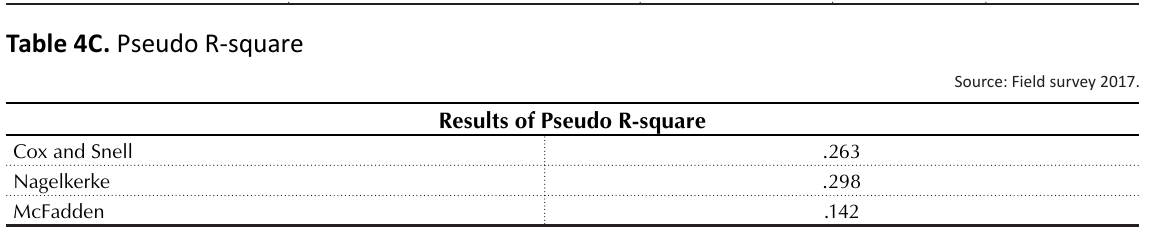
Table 5C. Likelihood ratio tests